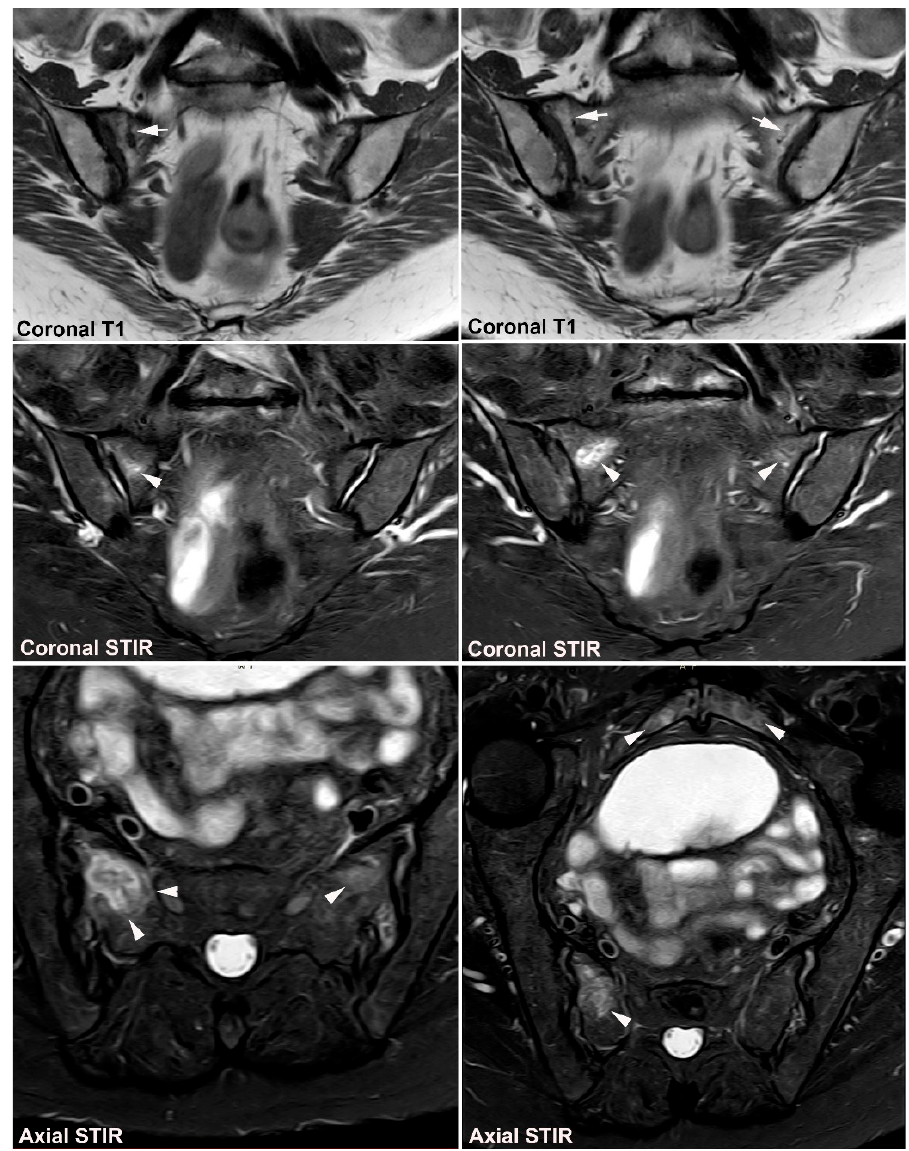
Figure 24. Sacral insufficiency fracture in osteoporosis. MRI in a 77-year-old woman with a Th12 osteoporotic fracture and low back pain. Two semi-coronal T1-weighted images (upper image row) and corresponding semi-coronal STIR images (middle image row) anteriorly in the joints in addition to semi-axial STIR images, one at the upper part and one at the middle part of the joint including the pubic bone. There is subchondral BME at the right SIJ (arrowheads) and an obvious fracture line is seen on the right side on the T1-weighted images in addition to a faint sclerotic line on the left side (arrows) with concomitant surrounding edema, best visualized on the axial images (arrowheads). The axial STIR image reveals concomitant bilateral subchondral BME at the symphysis (arrowheads) due to concomitant pubic fractures or bone bruise